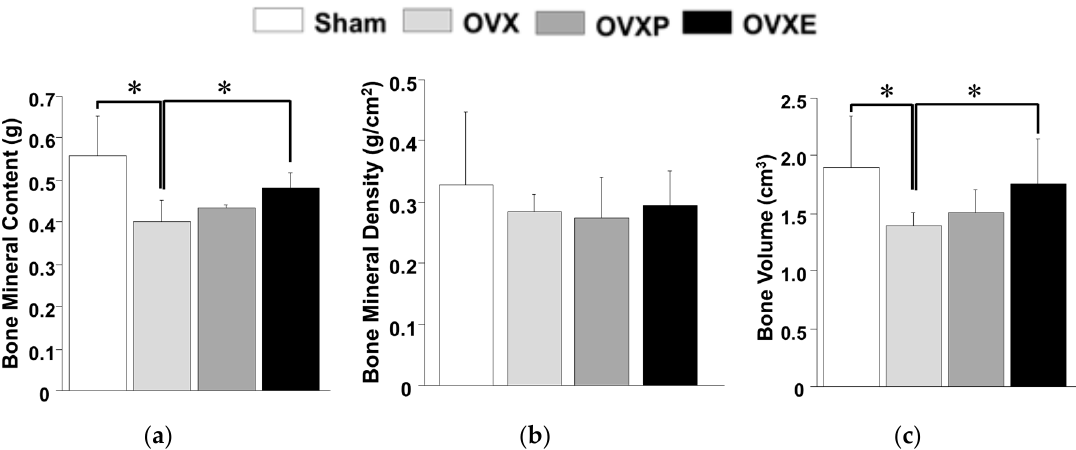
Figure 6. Analysis of dual-energy X-ray absorption for the lumbar vertebrae 4–6. ( a ) Bone mineral contents (BMC), ( b ) bone mineral density (BMD), and ( c ) bone volume (BV). * p < 0.05.